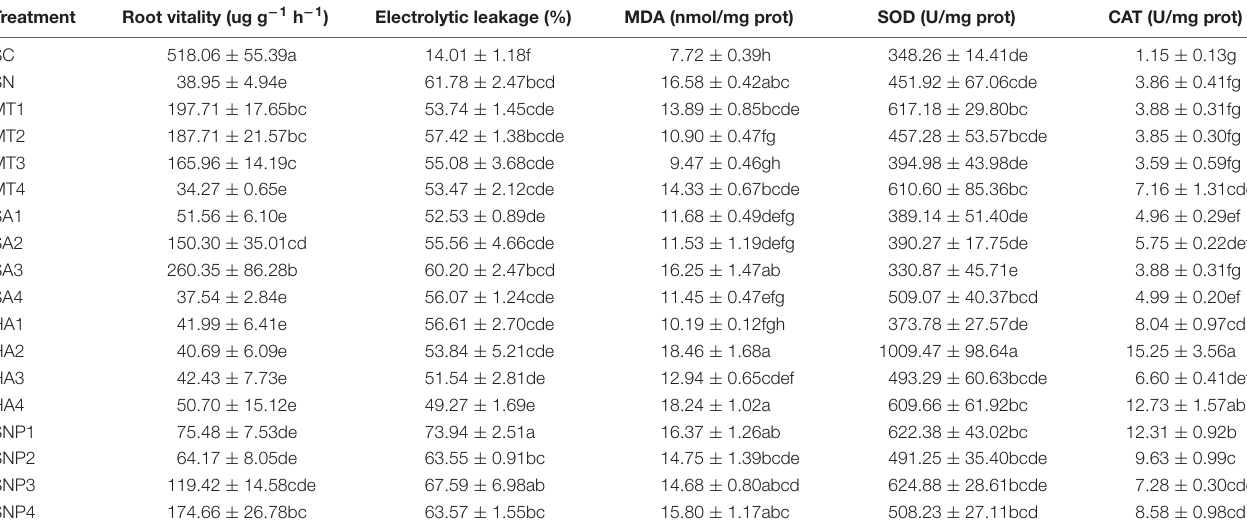
TABLE 4 | Effects of exogenously applied growth regulators on root activity, electrolytic leakage, total soluble protein, malondialdehyde (MDA) content, and antioxidant enzyme activities under high-nitrate stress.